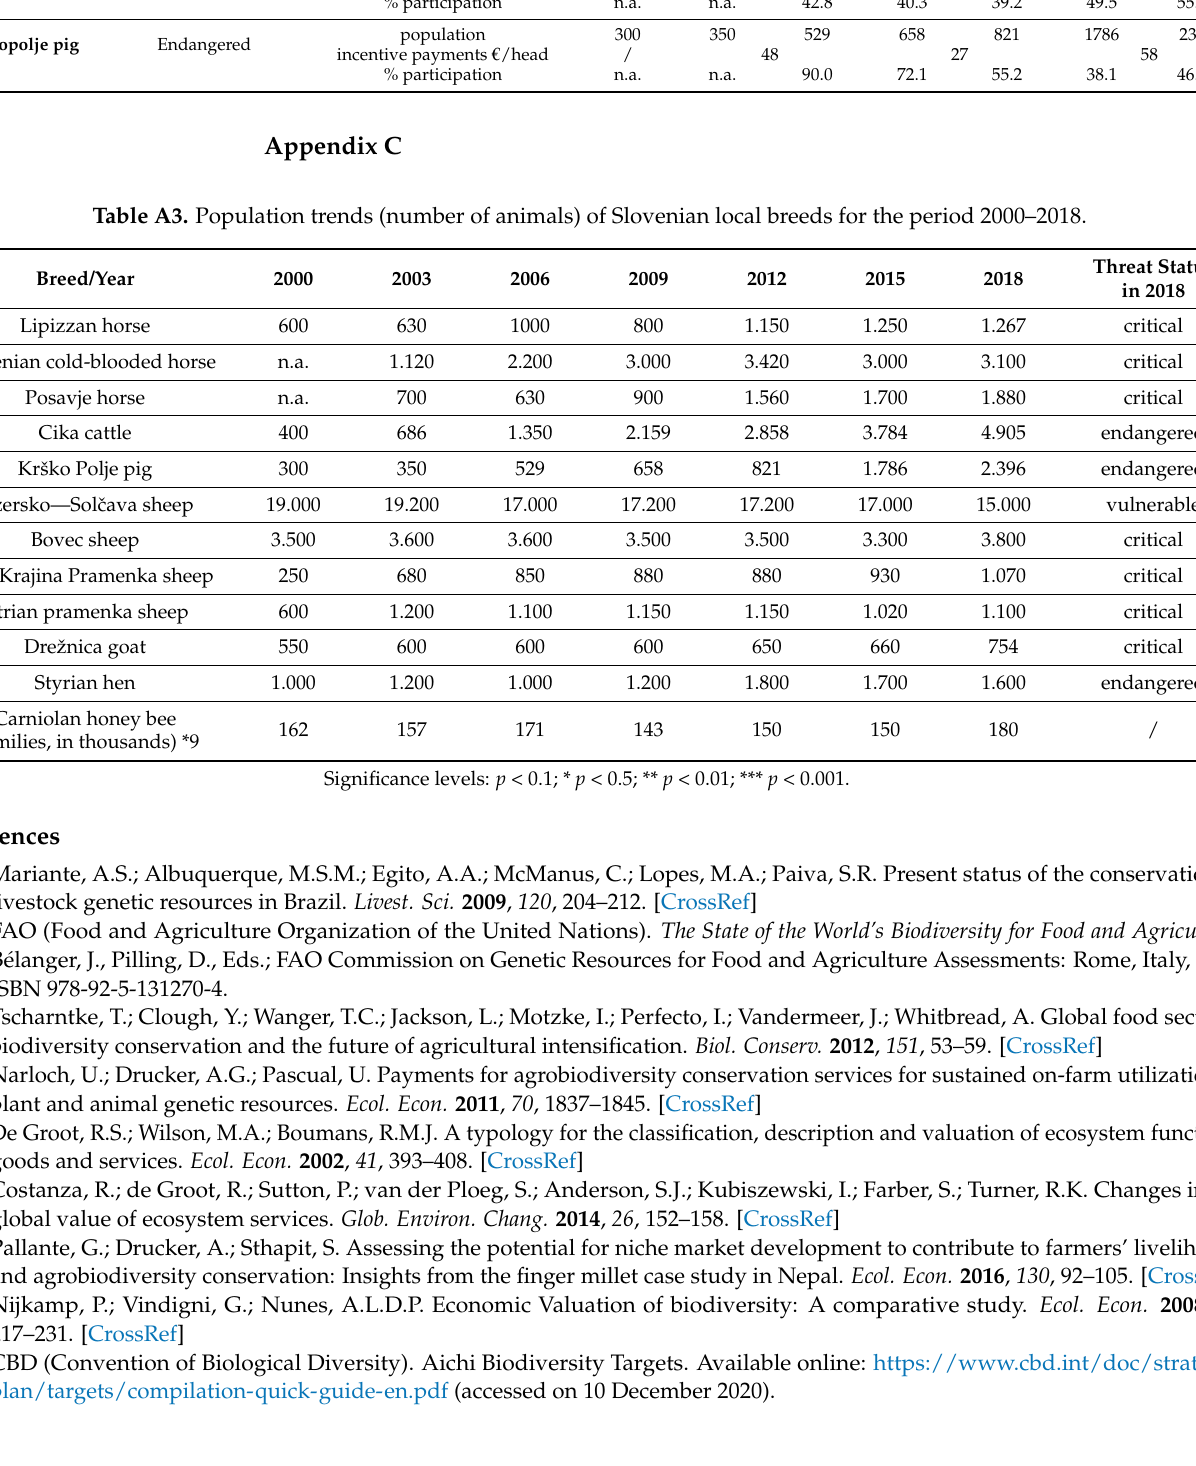
Table A2. Population trends (number of animals) and incentive payments for the three analysed breeds, for period 2000–2018. Breed